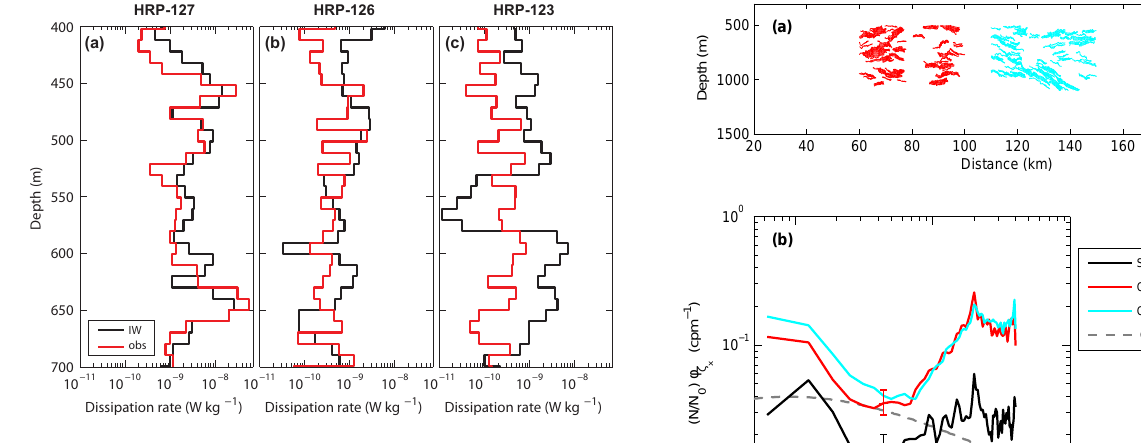
Fig. 10. Profiles of dissipation rate of turbulent kinetic energy (black) inferred using finescale internal-wave parameterization us- ing Eq. (1) (Gregg, 1989), and (red) measured by the microstructure shear-probes for HRP dives (a) 127 (b) 126 and (c) 123.